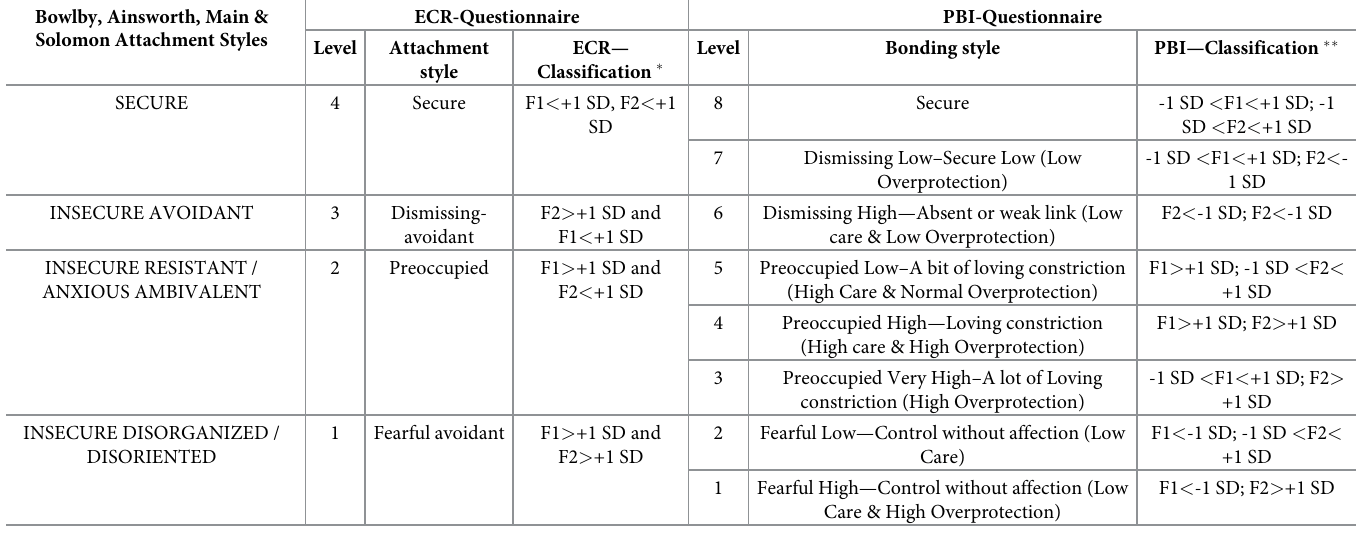
Table 2. ECR & PBI ordinal classifications ( � ECR Factors: F1-Anxiety, F2-Avoidance, Z scores; �� PBI Factors: F1-Care, F2-Overprotection, Z scores). Bowlby, Ainsworth, Main & Solomon Attachment